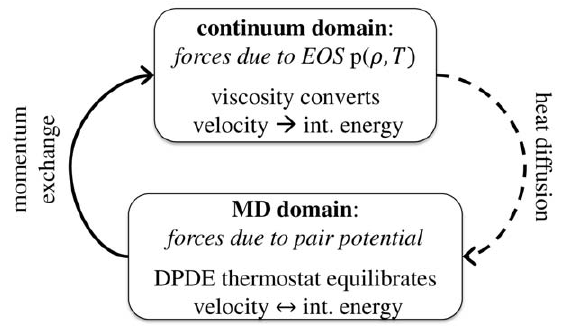
Figure 1. Sketch of the proposed continuum-MD coupling algorithm. Note that – at equilibrium – the flow is directed as shown because continuum viscosity irreversibly transforms nodal velocity into internal energy (see text for a detailed